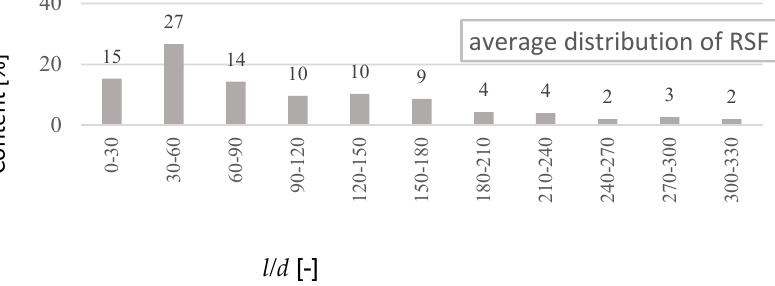
Figure 6. Average percentage RSF slenderness ( l/d ) distribution. Table 1. Mechanical and geometrical features of RSF.